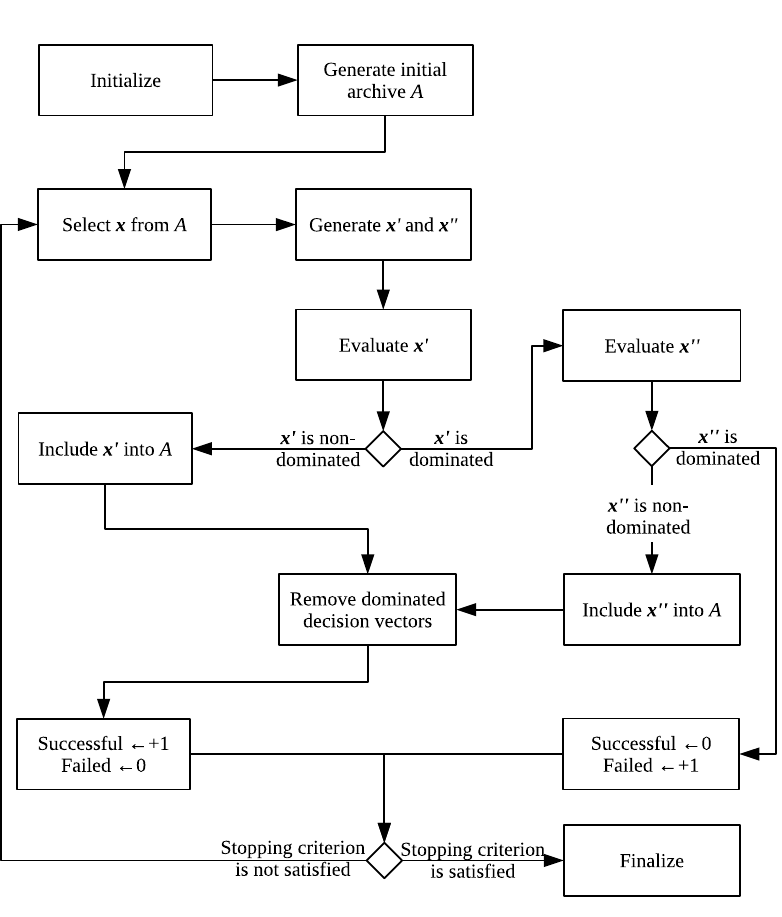
Figure 2. Scheme of MOSS